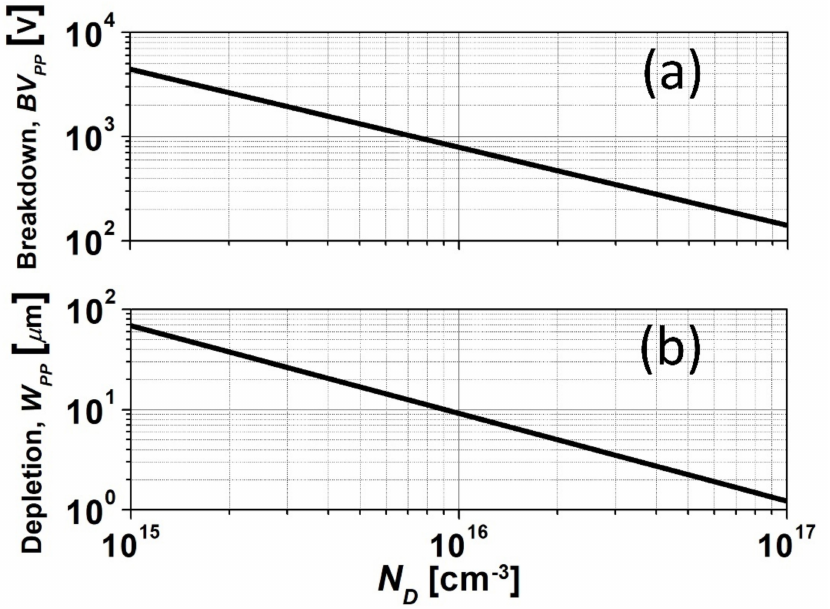
Figure 2. ( a ) Parallel plane breakdown voltage ( BV PP ) and ( b ) depletion width ( W PP ) as a function of doping ( N D ) for